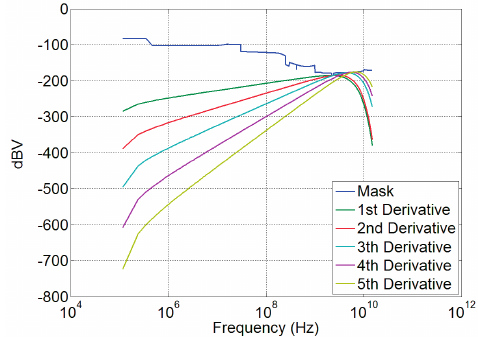
Figure 7. Spectral density limits for the analyzed antenna input voltage. RBW = 1 MHz >> PRF.